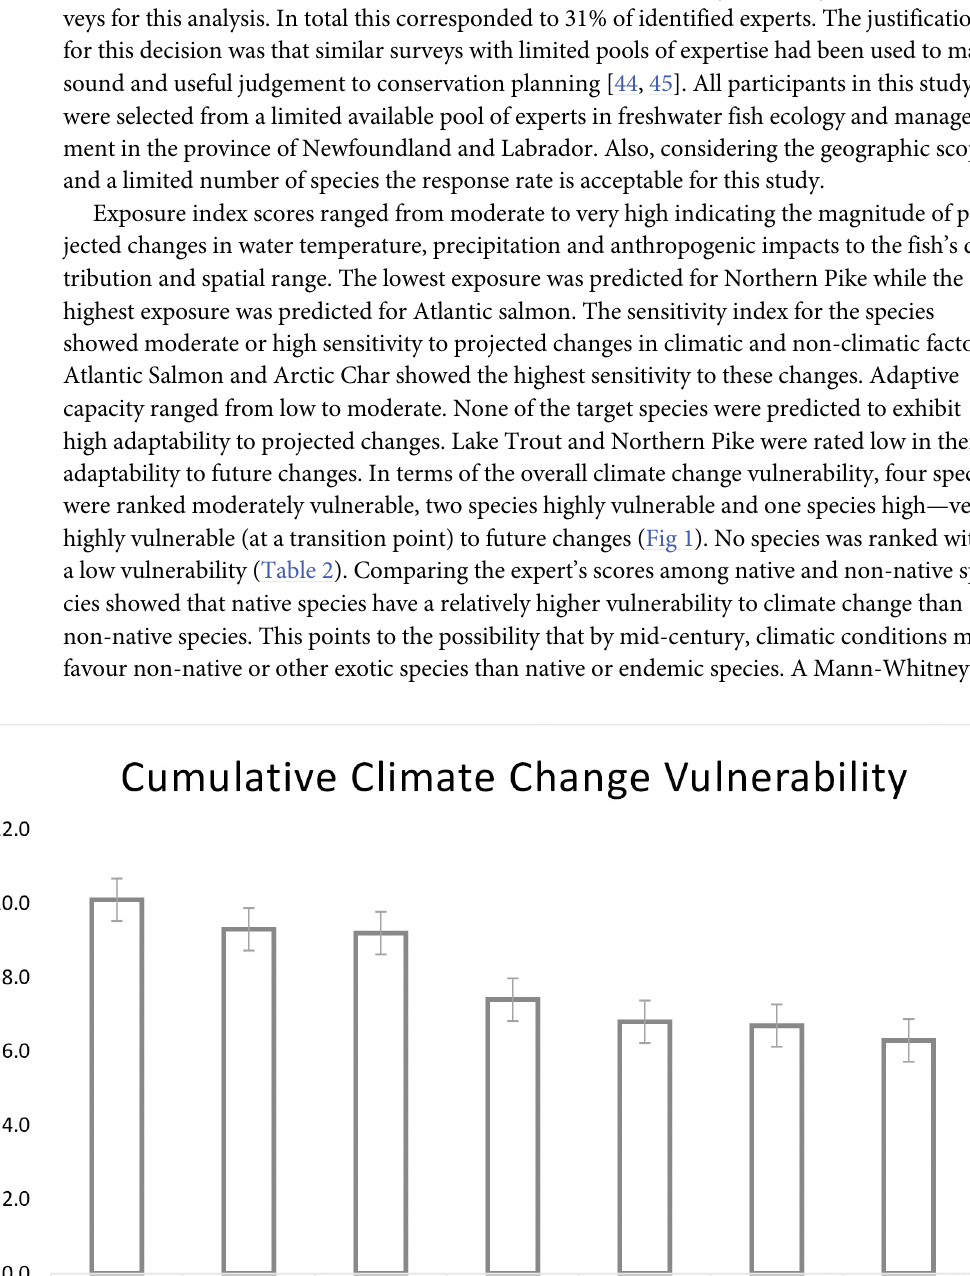
PLOS ONE | https://doi.org/10.1371/journal.pone.0208182 December3,